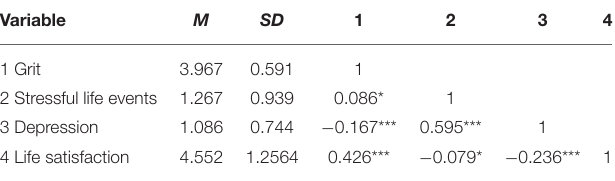
TABLE 1 | Descriptive statistics and